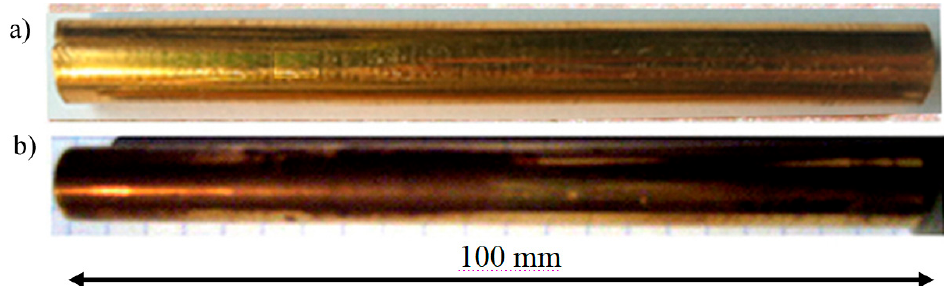
Figure 2. Photograph of electrodes after monthly use in a plasma reactor: ( a ) gold electrode, ( b ) copper electrode galvanized with gold and matte after use.